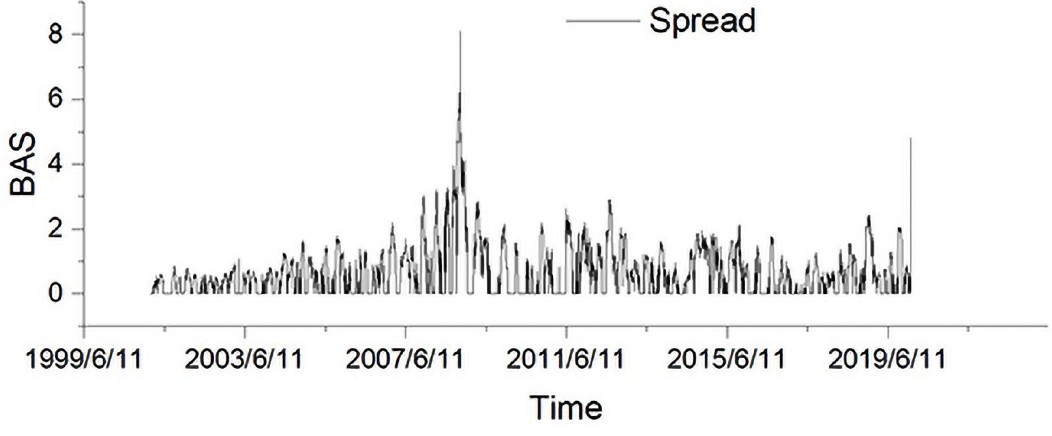
Fig 4. Daily bid-ask spread plotting.